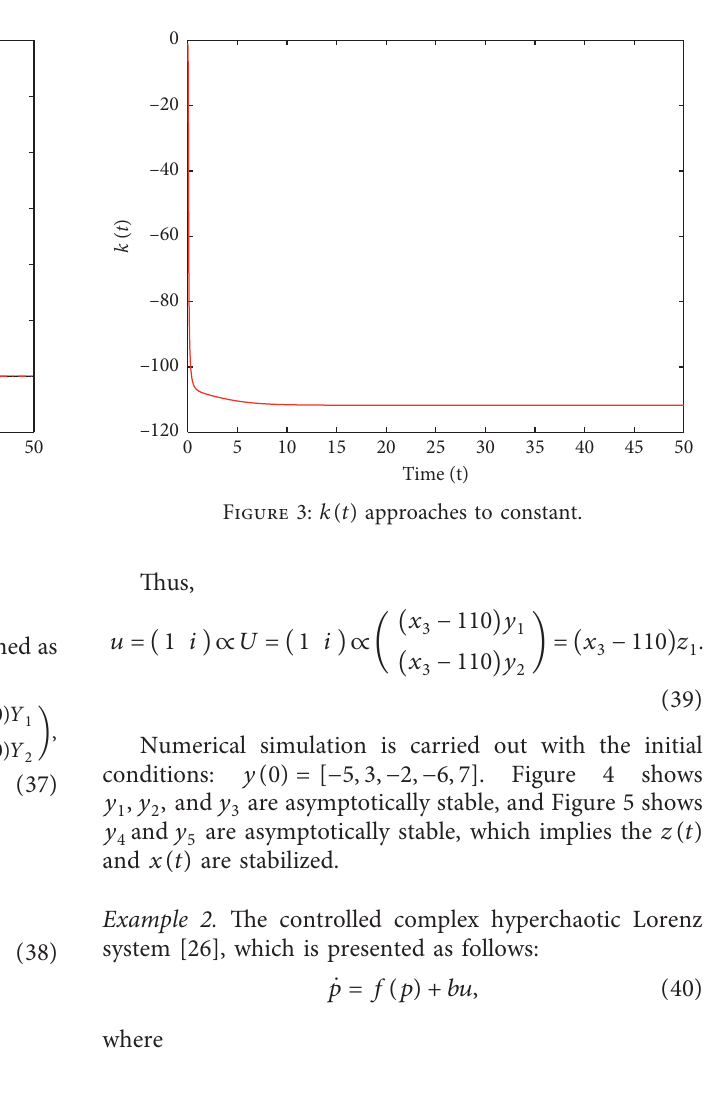
,y , and y are asymptotically stable. 1 2 3